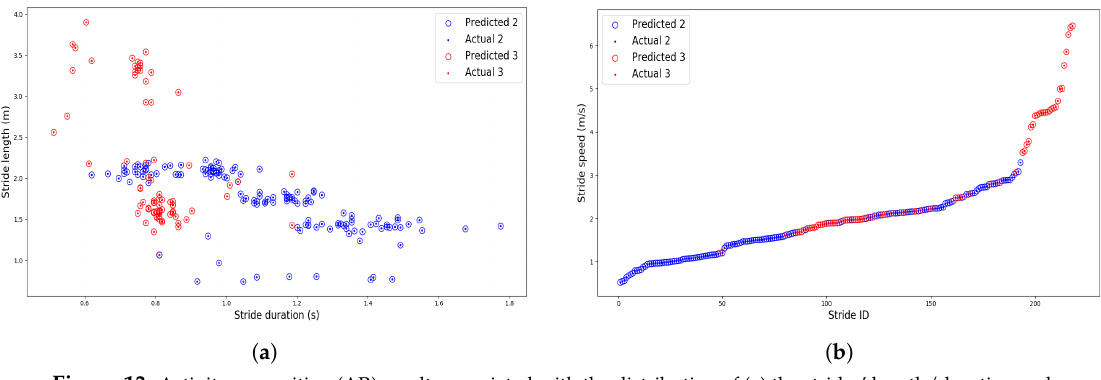
Figure 13. Activity recognition (AR) results associated with the distribution of ( a ) the strides’ length/duration and ( b ) the strides’ speed.